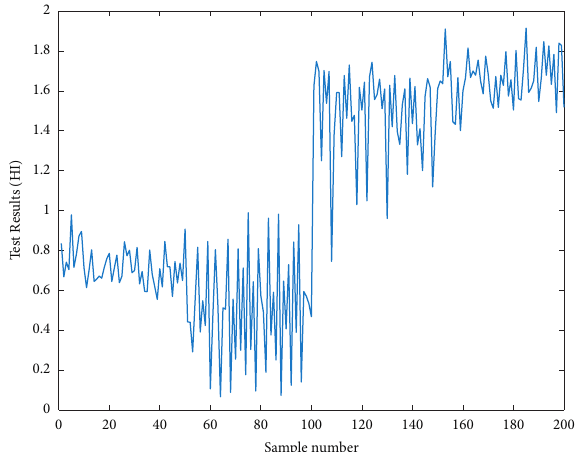
Figure 7: Evaluation chart of feature extraction through orthogonal wavelet transformation.